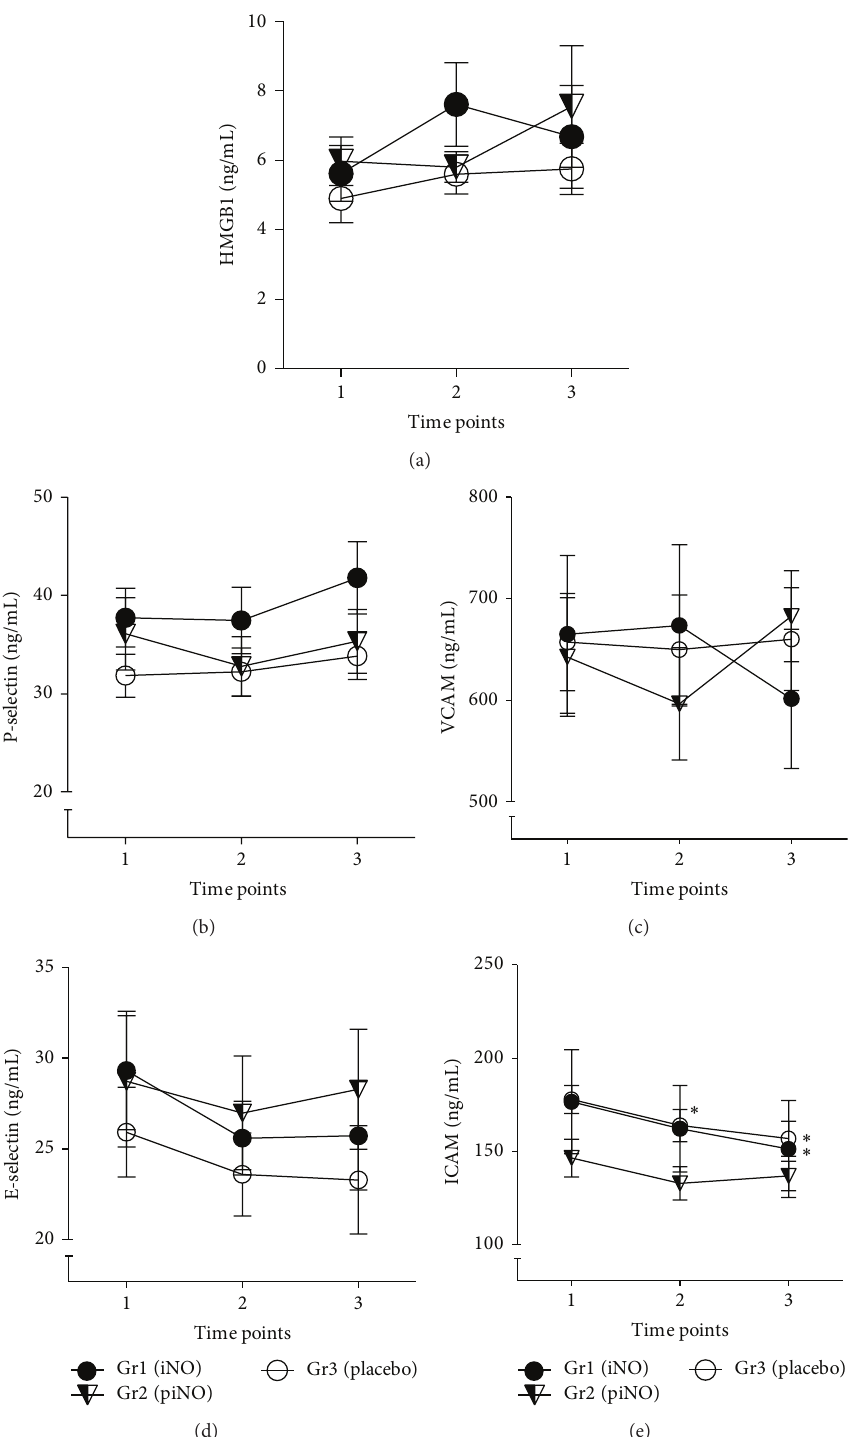
Figure 2: Effects on soluble adhesion molecules and HMGB1 in plasma. A significant decrease in ICAM was observed in group 1 (iNO) at time point 3 (two hours after tourniquet release) and in group 3 (placebo) at time points 2 (at the end of operation) and 3. No differences were observed between the groups. ∗ 𝑃 < 0.05 compared with baseline. Mean ±